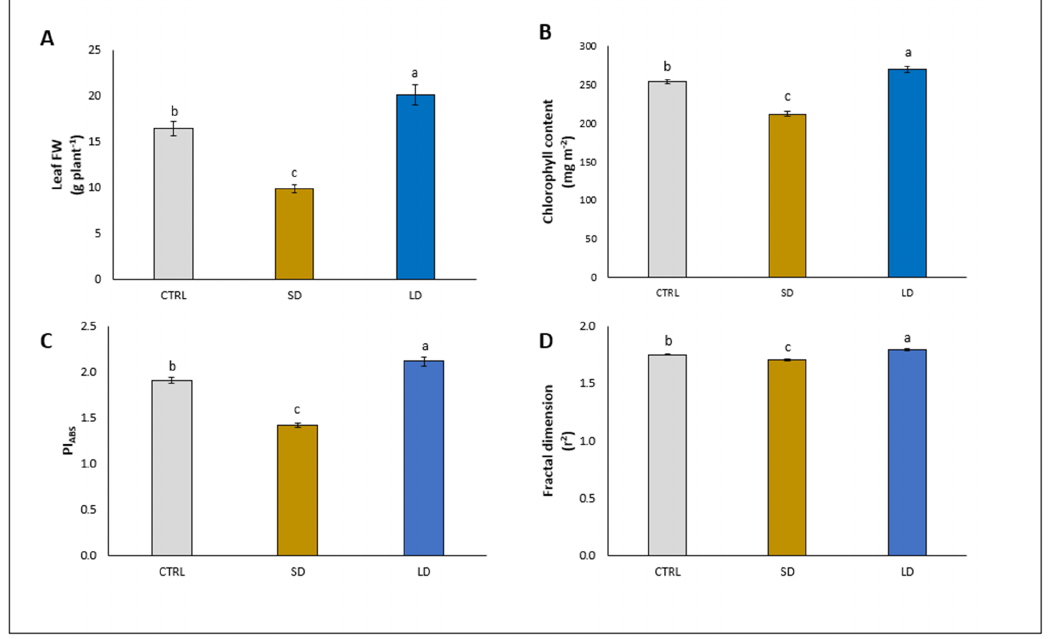
Figure 2. Leaf fresh weight (FW) ( A ), chlorophyll content ( B ), performance index (PI ABS ) ( C ), and fractal dimension ( D ) in leaves of lettuce plants grown for 5 weeks without (CTRL) and with the application of digestate, either solid (SD) or liquid (LD). Parameters are expressed as mean ± standard error. Different letters indicate statistically significant differences ( p < 0.05).